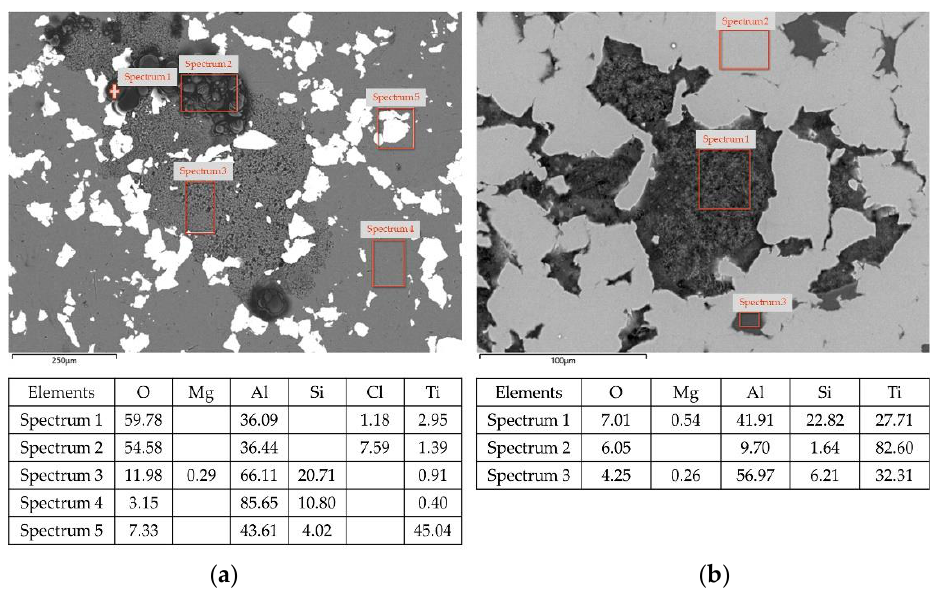
Figure 11. SEM images. EDS analysis in different regions of the specimen and relative quantitative composition in weight percentage. ( a ) Ti20Al80 sample; ( b ) Ti80A20 sample.